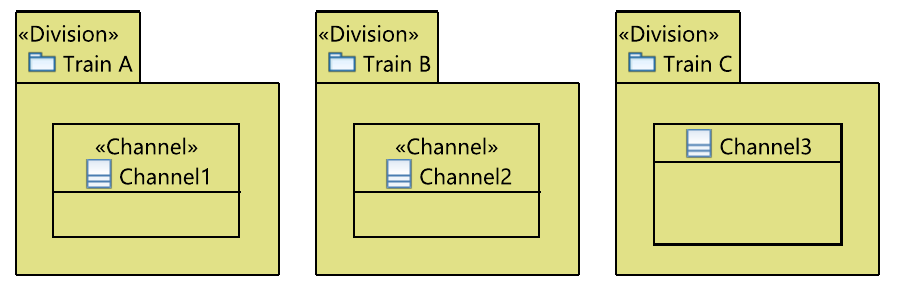
Figure 21. Divisions and channels.